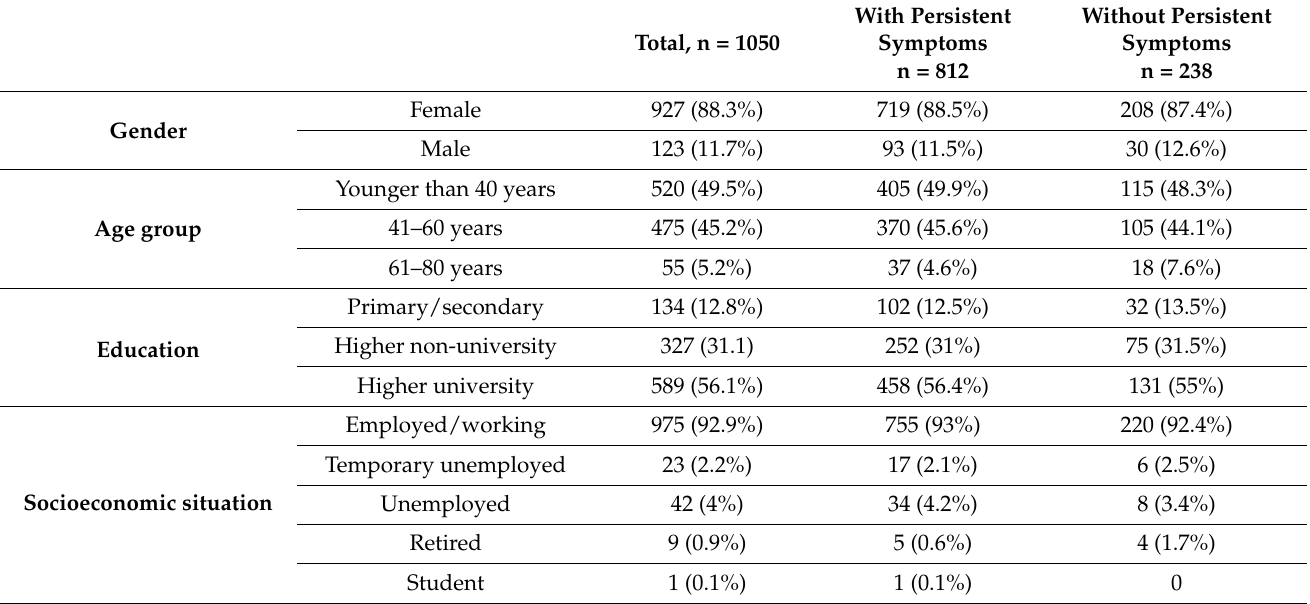
Table 1. Socioeconomic characteristics of participants are presented as numbers and percentages in the total cohort and in both subgroups (with and without persistent